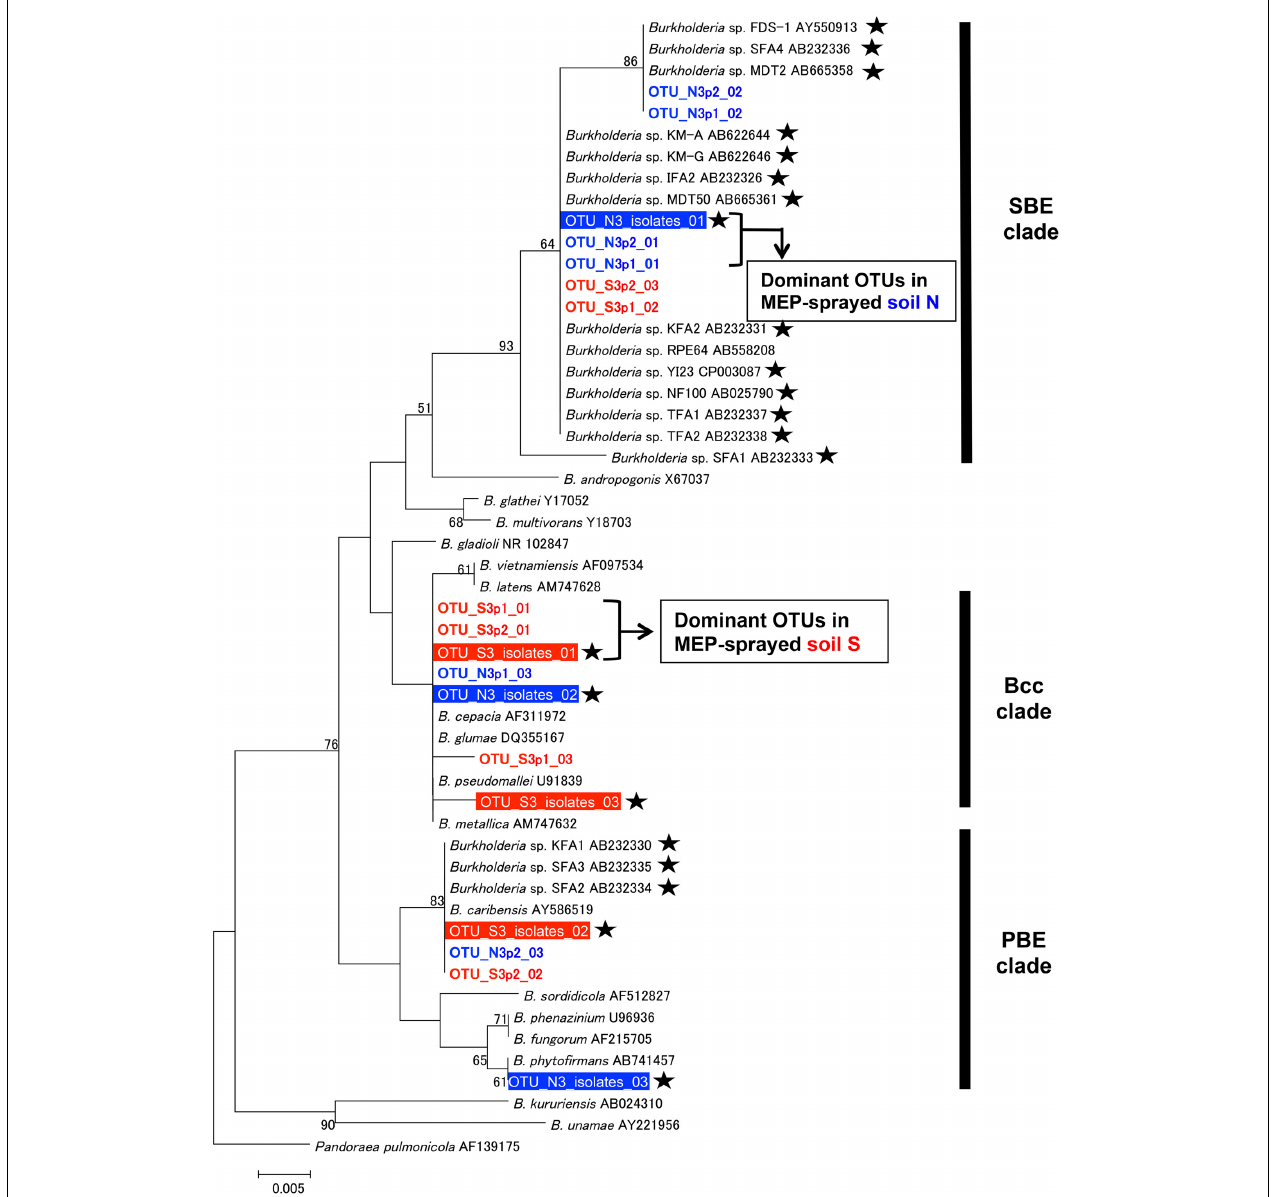
FIGURE 6 | Phylogenetic analysis of Burkholderia strains dominating in MEP-sprayed soils. A neighbor-joining tree inferred from aligned 255bp sequences of 16S rRNA gene is shown. Phylogenetic placements of OTUs (OTUs at 100% identity thresholds) of Burkholderia , identified from the MEP-degrading isolates and deep sequences, were estimated. Among dominant OTUs in each soil samples, top 3 OTUs (see Figure 5 ) were included in the analysis. Red and blue colored OTUs are detected from soil S and soil N, respectively. Outline letters on a filled background indicate OTUs determined by the isolation. Colored letters on a white